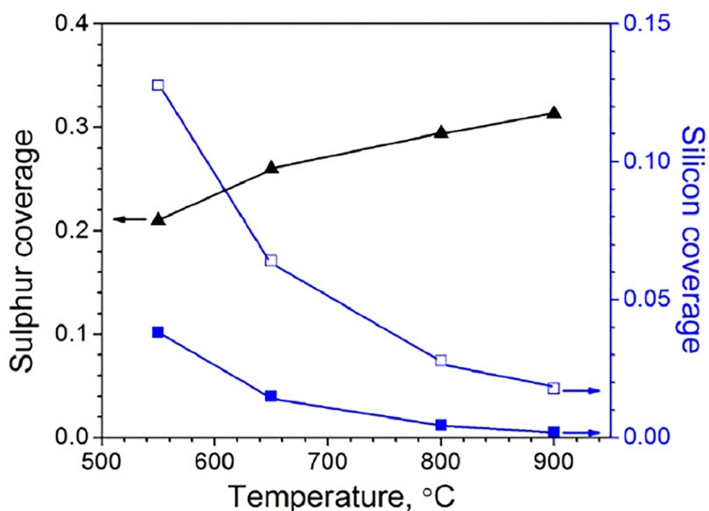
Figure 15. The equilibrium coverage of sulphur and silicon during their competitive segregations onto the surface of Fe9Cr0.5Si alloy, open symbol: C S = 0; solid symbol: C S reaches the upper limit of sulphur solubility [93]. Reproduced with permission from Elsevier.